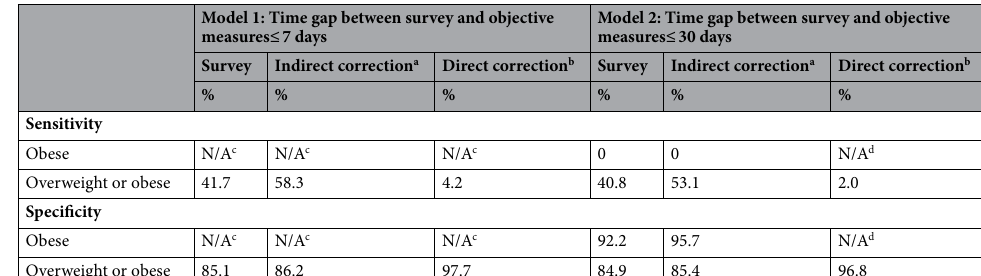
Table 4. Sensitivity and specificity of reported and corrected outcomes. a Indirect correction used the corrected weight and height values to calculate corrected BMI to classify overweight or obese status. b Direct correction used the corrected BMI predicted by the model to classify overweight or obese status. c N/A as no child was classified as obese based on objective measures. d N/A as no child was classified as obese based on predicted